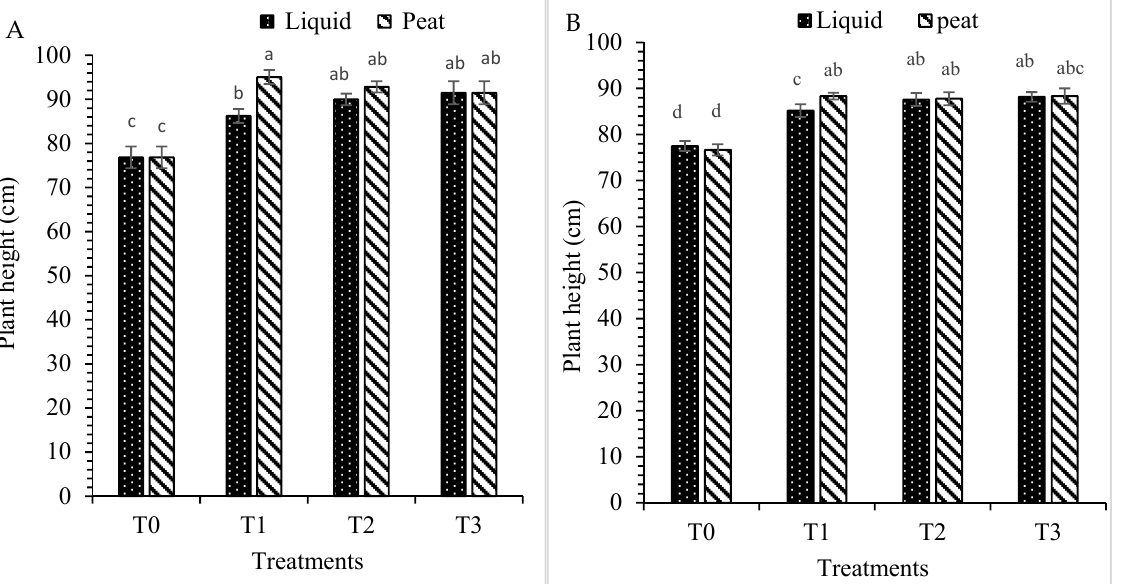
Figure 2. Plant height of soybean plants subjected to liquid formulation (T0 = 0 mL, T1 = 150 mL, T2 = 300 mL and T3 = 150 mL) and peat formulation of Bradyrhizobium japonicum (T0 = 0 mg, T1 = 250 mg, T2 = 500 mg and 150 mL) in bioclimatic zone (( A ) = Bronkhorspruit/Gauteng) and (( B ) = Hartbeesfoein/North West province). Bars sharing a letter are not significantly different (Lsd zone A) = 8.749 and (Lsd zone B) = 5.124. Data are means ± standard errors.